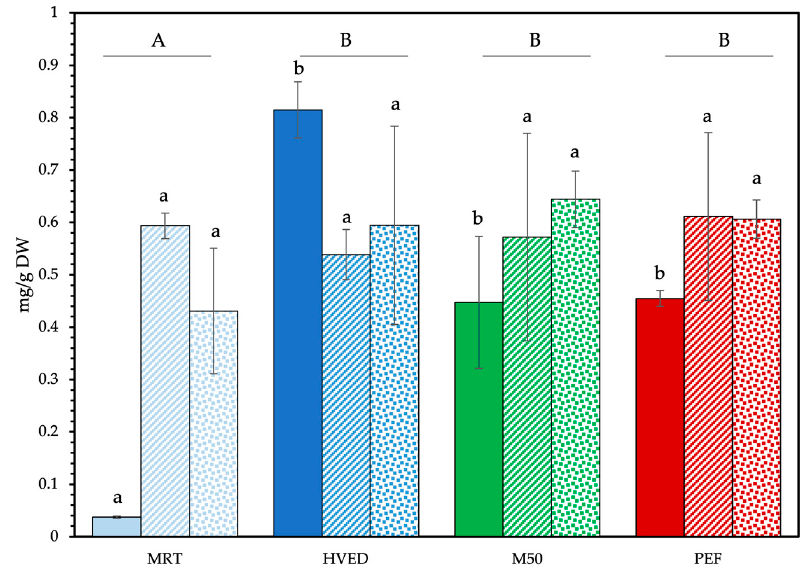
Figure 3. Final total MAA yields. Solid fill: fresh GC; dashed fill: dry GC; dotted fill: powder GC. Upper case letters display differences between treatments (values averaged across state, n = 12). Lower case letters denote significant differences between treatments by sate n = 3). Type III ANOVA with Tukey post-hoc test. Table 2. MAA contents in GC extracts identified and quantified using untargeted ddMS2/MS3 anal- ysis.